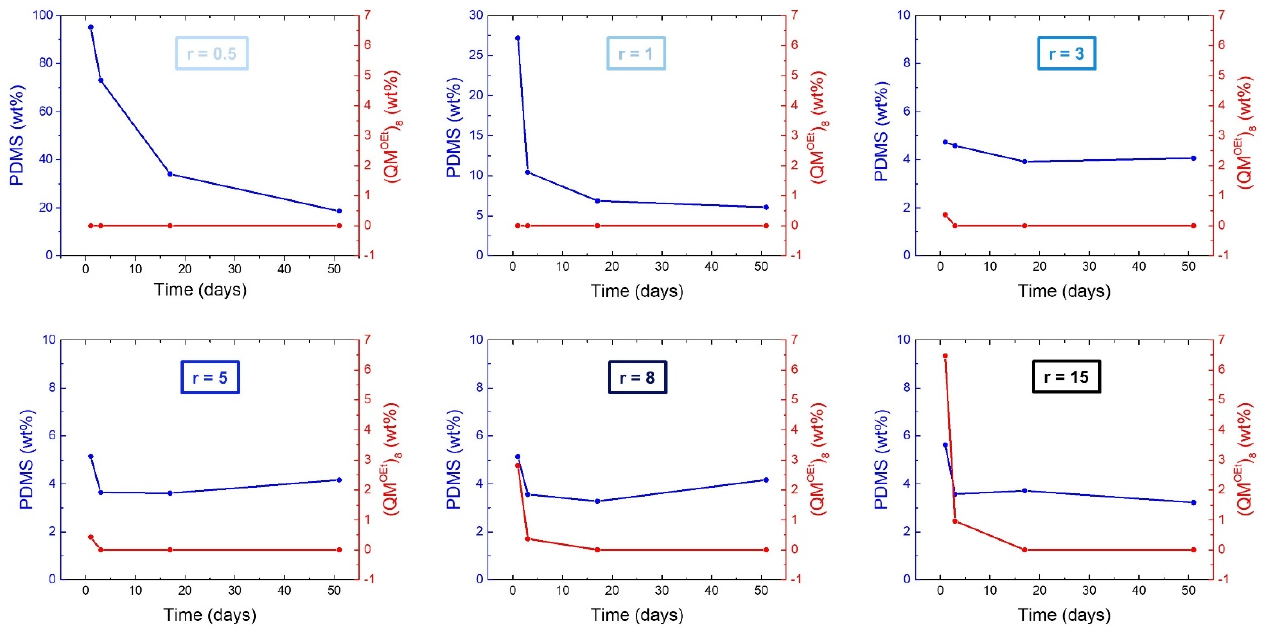
Figure 7. The amount of extractable PDMS and (QM OEt ) 8 as a function of time. Elastomers were prepared via the reaction between C2T and (QM OEt ) 8 using stoichiometric ratios of 0.5, 1, 3, 5, 8, and 15, respectively.